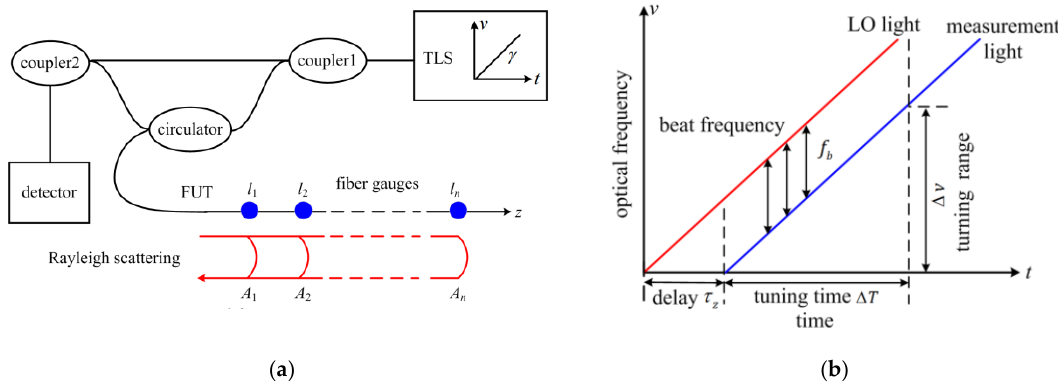
Figure 1. Basic principle of optical frequency domain reflectometer (OFDR). ( a ) schematic diagram of a basic OFDR configuration. ( b ) interference between local oscillator (LO) and measurement light.